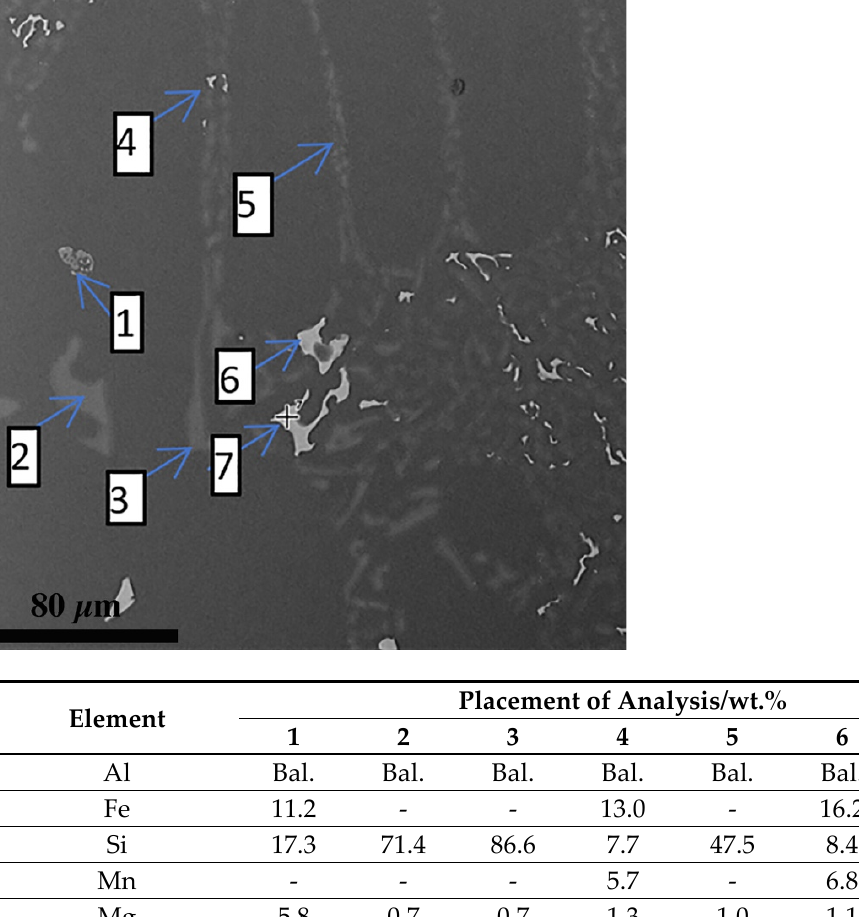
Figure 11. Chemical composition analysis of indicated phases after casting (SEM–EDS).